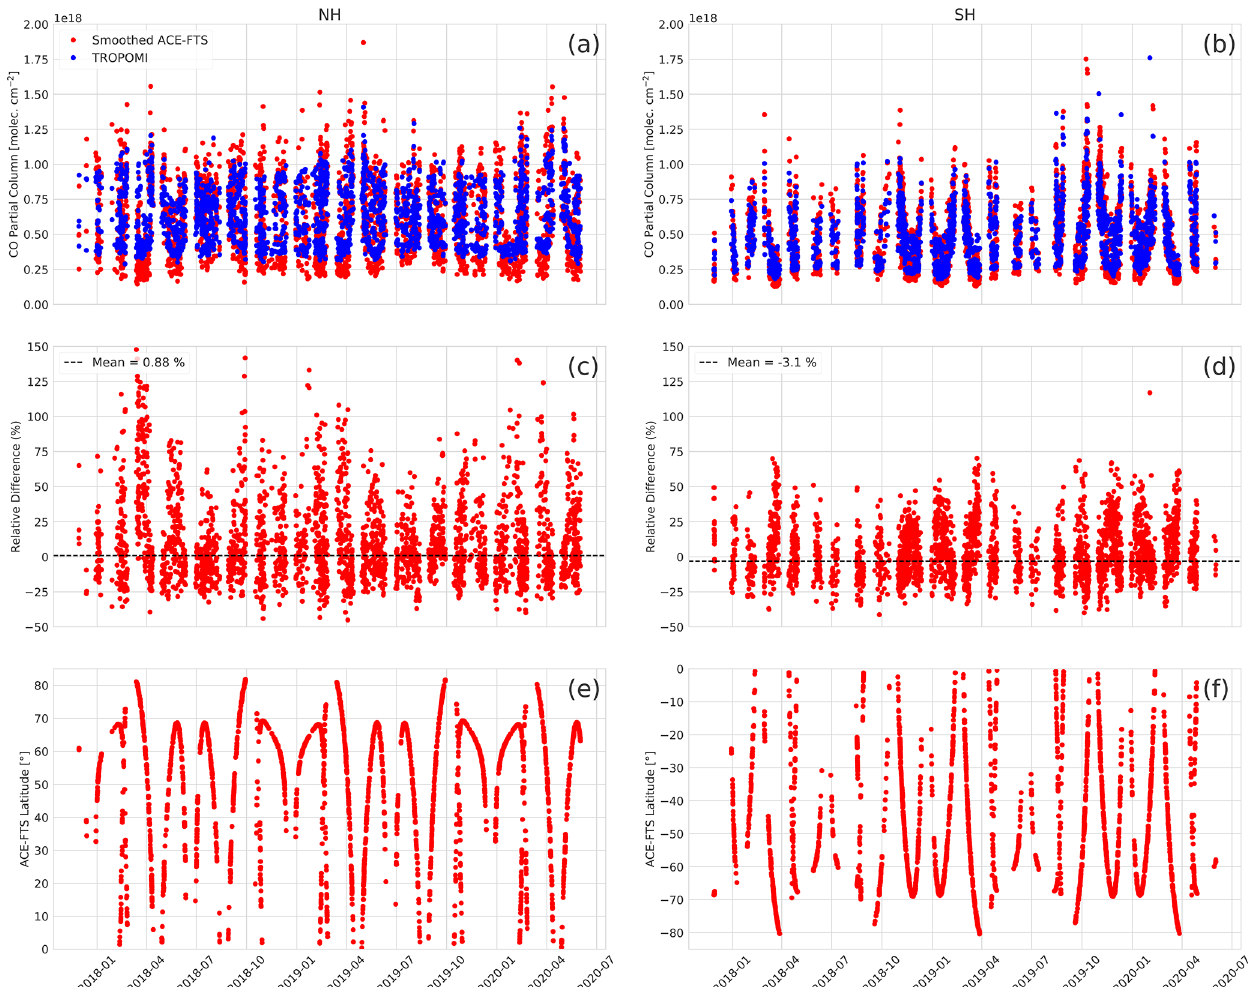
Figure 3. (a, b) Time series of smoothed ACE-FTS and TROPOMI partial columns, (c, d) the relative differences between the instruments, and (e, f) the latitude of the coincident ACE-FTS measurement for both the Northern Hemisphere ( a, c, d ) and the Southern Hemisphere ( b, d, e ). The black dashed horizontal lines in the middle panels denote the mean of the